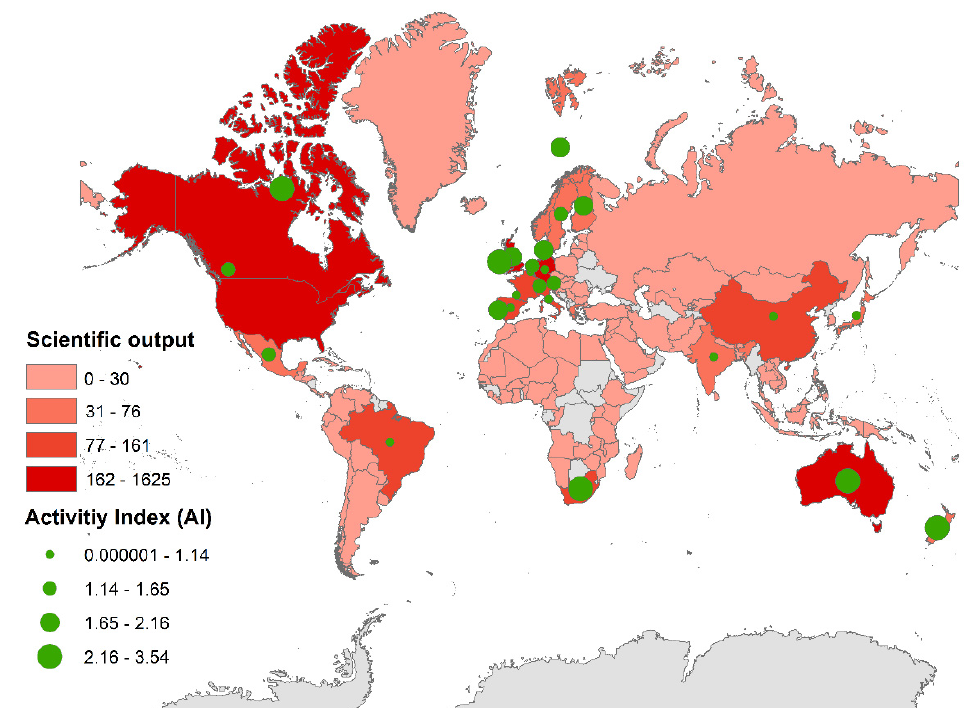
Figure 2. Publications on citizen science: output and activity index by country. Publications 2018 , 6 , x FOR PEER REVIEW